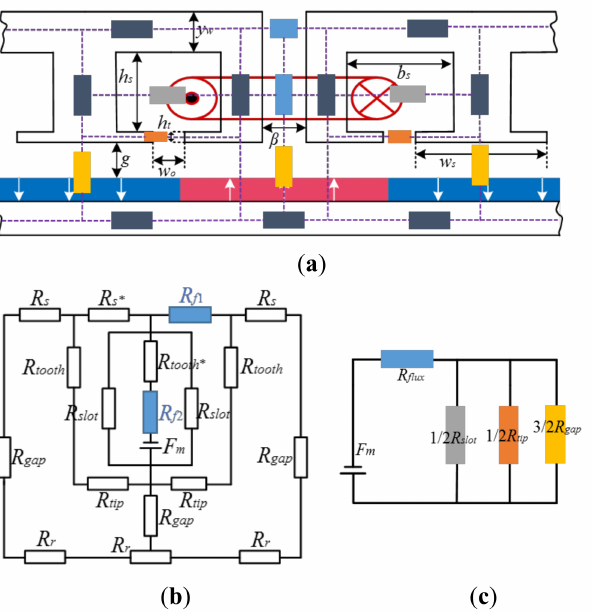
Figure 6. The equivalent reluctance network model of armature tooth flux barrier machine. ( a ) The cross section model of phase A. ( b ) Equivalent reluctance network model of phase A. ( c ) Simplified reluctance network model of phase A.